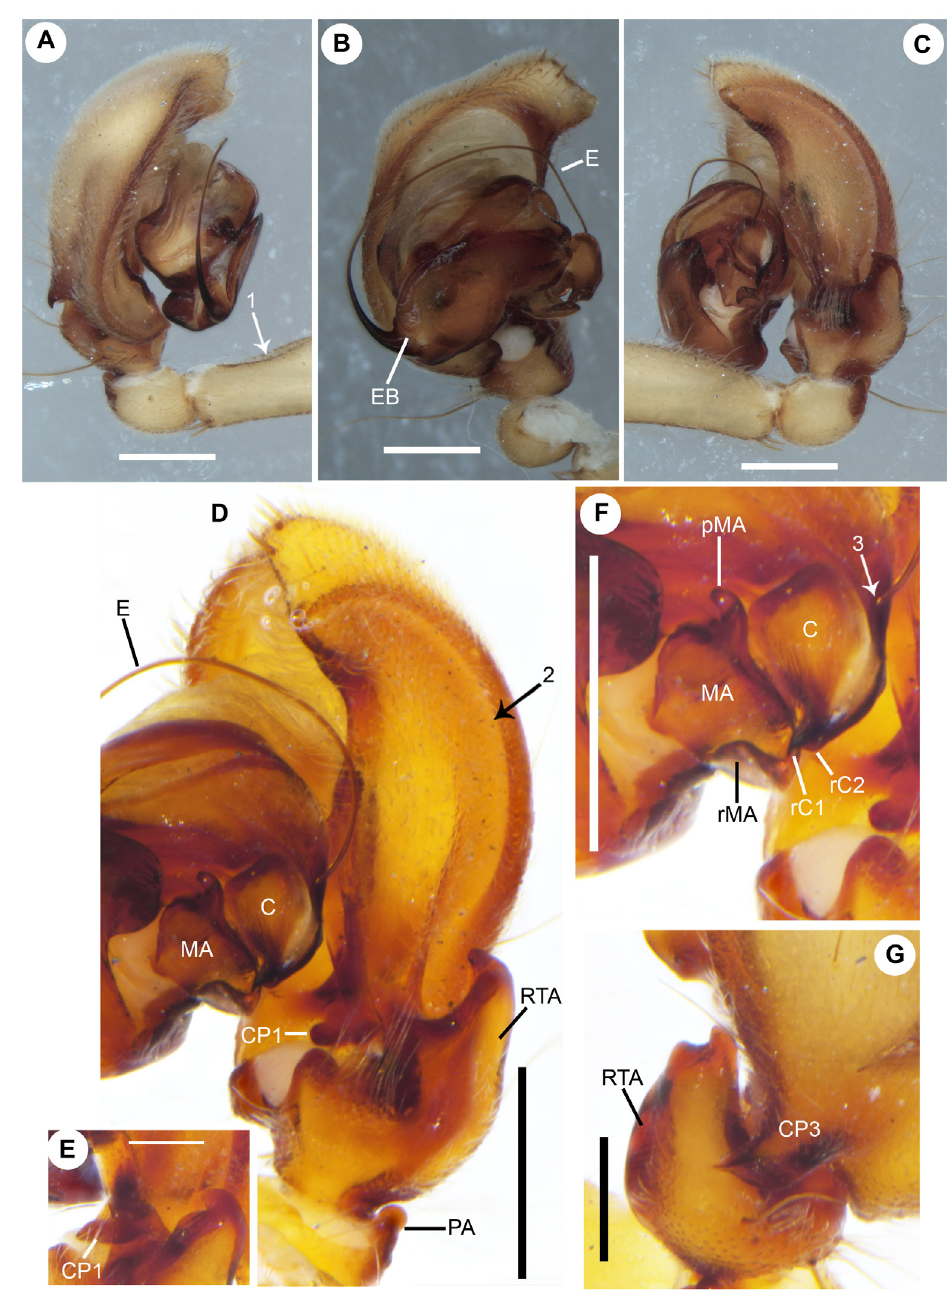
Fig. 8. Laminion gujaratensis (Tikader & Patel, 1975) gen. et comb. nov., ♂, holotype of Storena gujaratensis Tikader & Patel, 1975. A . Left pedipalp, prolateral view; arrow 1 indicates femoral disto- ventral depression. B . Same, ventral view. C–D . Same, retrolateral view; arrow 2 indicates cymbial retrolateral flange. E . First cymbial process, dorso-retrolateral view. F . Median apophysis and conductor, retrolateral view; arrow 3 indicates embolic tip. G . Retrolateral tibial apophysis and third cymbial process, dorsal view. Abbreviations: C = conductor; CP1 = first cymbial process; CP3 = third cymbial process; E = embolus; EB = embolic base; MA = median apophysis; PA = patellar apophysis; pMA = prolateral branch of median apophysis; rC1 = first retrolateral branch of conductor; rC2 = second retrolateral branch of conductor; rMA = retrolateral branch of median apophysis; RTA = retrolateral tibial apophysis. Scale bars: A–C = 0.5 mm; D–G = 0.2